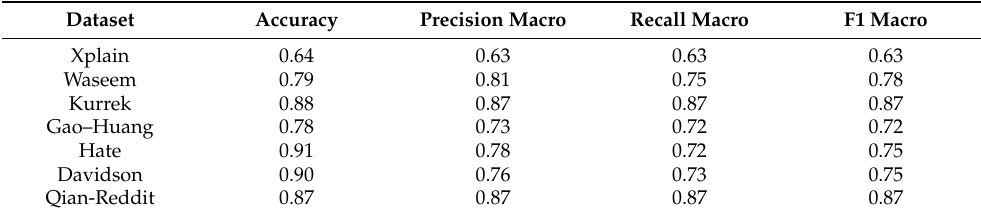
Table A11. Scores obtained on the benchmark Datasets using the hard learning multi-task model. Embedding vectors were made with both ELMo and GloVe and then concatenated. The auxiliary Dataset is the SemEval 18 [27] Task1 Dataset.